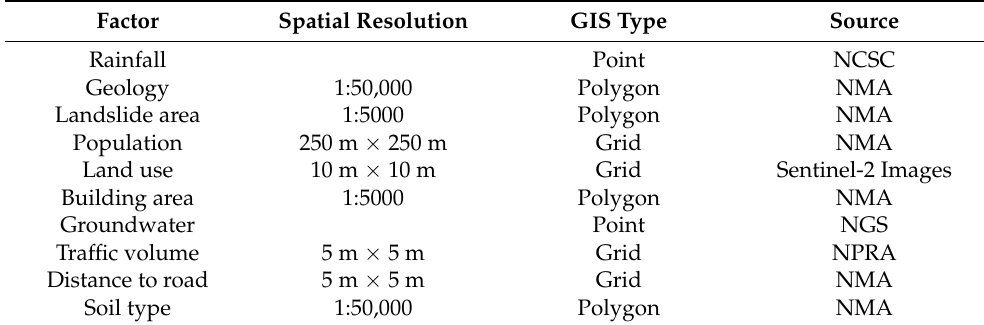
Table 2. Environmental factors in this